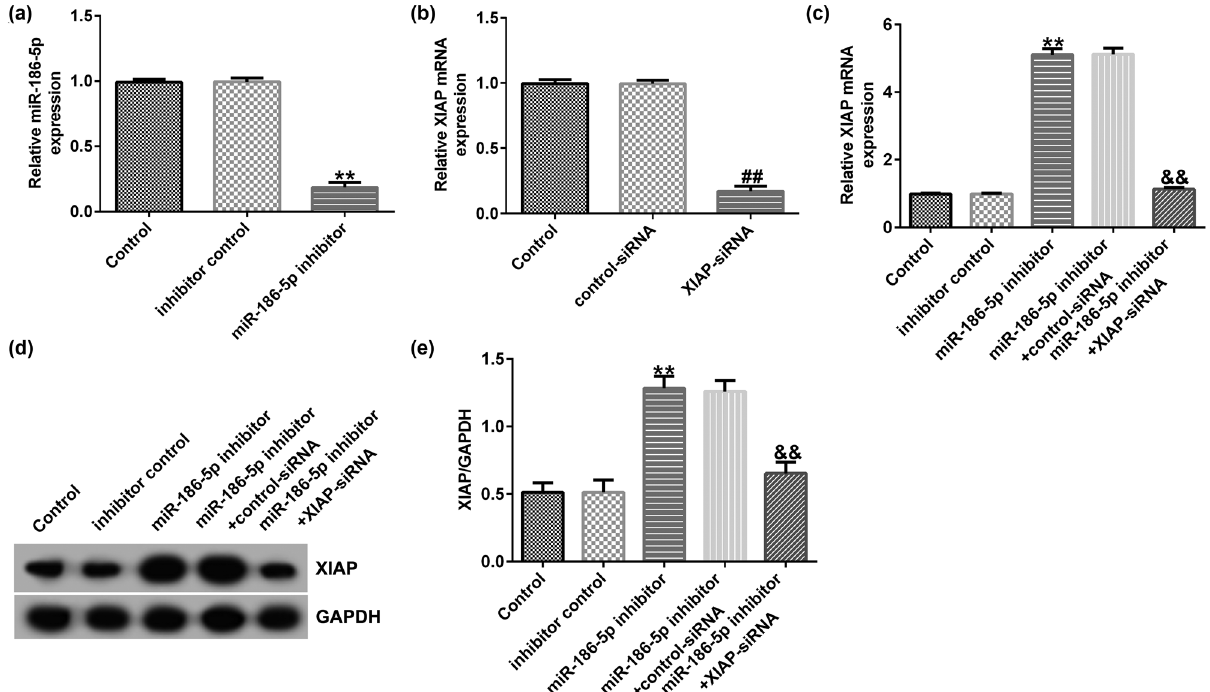
Figure 6: miR - 186 - 5p negatively regulates XIAP expression levels in SH - SY5Y cells. ( a ) RT - qPCR assay results showing miR - 186 - 5p expression levels in SH - SY5Y cells transfected with the inhibitor control or miR - 186 - 5p inhibitors. ( b ) RT - qPCR assay results showing XIAP expression levels in SH - SY5Y cells transfected with the control or XIAP siRNAs. ( c ) RT - qPCR assay results showing XIAP expression levels in SH - SY5Y cells transfected with the miR - 186 - 5p inhibitor + control siRNA or miR - 186 - 5p inhibitor + XIAP siRNA. ( d ) Western blotting analysis results showing the protein expression levels of XIAP. ( e ) XIAP/GAPDH. ** P < 0.01 vs control inhibitor group; ## P < 0.01 vs control siRNA group; && P < 0.01 vs miR - 186 - 5p inhibitor + control siRNA group. GraphPad Prism 6.0 software ( GraphPad Software, Inc. ) was used for creation of the fi